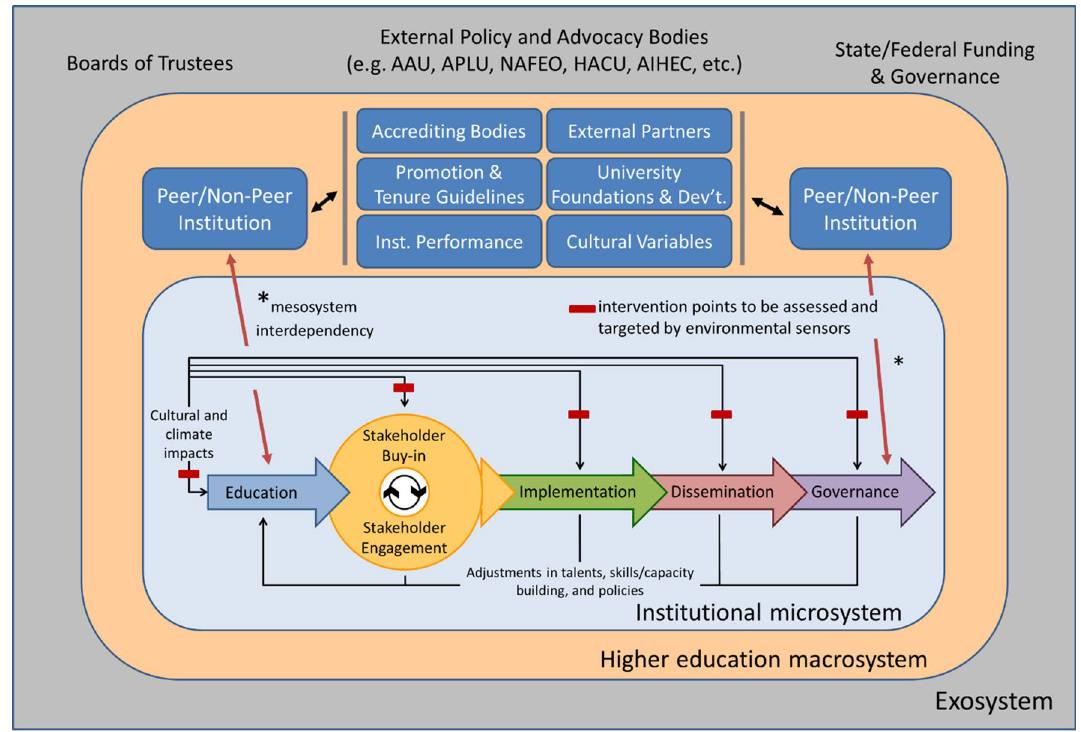
Fig. 1 Academic institutional-change centered ecosystem model. Institutional microsystem (in light blue box): Local institutions must focus on institutional transformation by facilitating and integrating local education, followed by buy-in and engagement of stakeholders, sub- sequently followed by moving to the action of implementation, dissemination, and promoting sustainable change through governance. Red bars represent environmental sensors who function to assess change and promote interventions for change and innovation (adapted from Montgomery [32]). Feedback from the paradigm supports adjustments in talent, skills/capacity building, ad policies, the latter of which determines how change, rather than stagnation or status quo, occurs in a system. Higher education macrosystem (in light orange box): Efforts at a local institution are impacted through mesosystem interdependencies (red arrows traversing local institution ecosystem and higher education ecosystem) including evaluations of peer and non-peer institutions (as denoted by traditional hierarchical frameworks